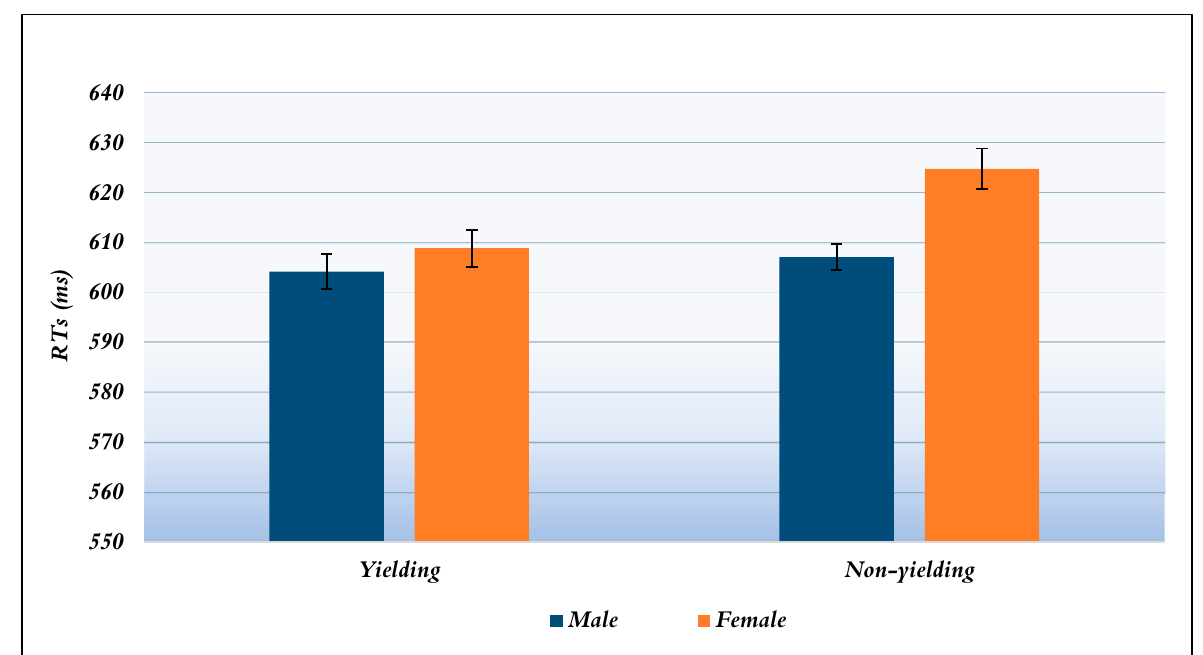
Figure 2. Mean RTs for crossing intention in the presence of yielding and non-yielding AVs for emotional and conversational facial expressions. Error bars represent standard error.